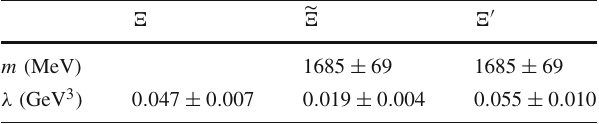
Table 2 The sum rule results for the masses and residues of the first orbitally and radially excited (cid:2) baryon as well as residue of the ground